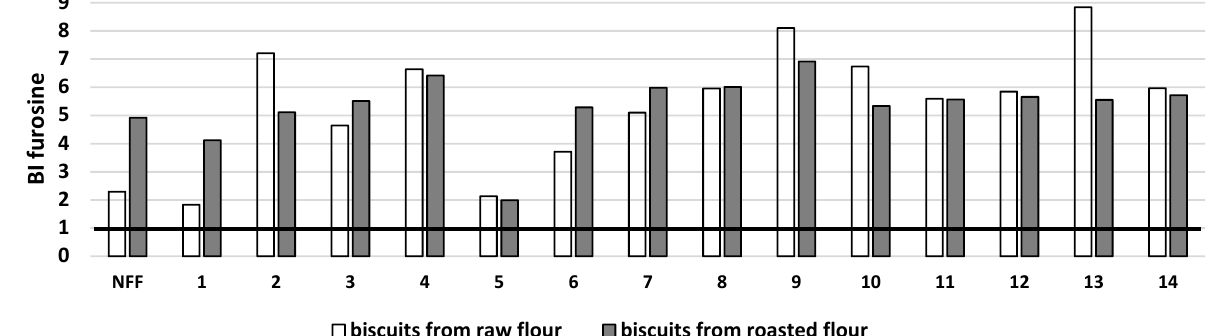
Figure 3. Potential bioaccessibility of furosine (BI furosine) from buckwheat biscuits baked from raw or roasted buckwheat flour fermented by selected strains of lactic acid bacteria. NFF—nonfermented flour. Flours fermented by: 1 —Lactiplantibacillus plantarum IB; 2— Lactiplantibacillus plantarum W42; 3—